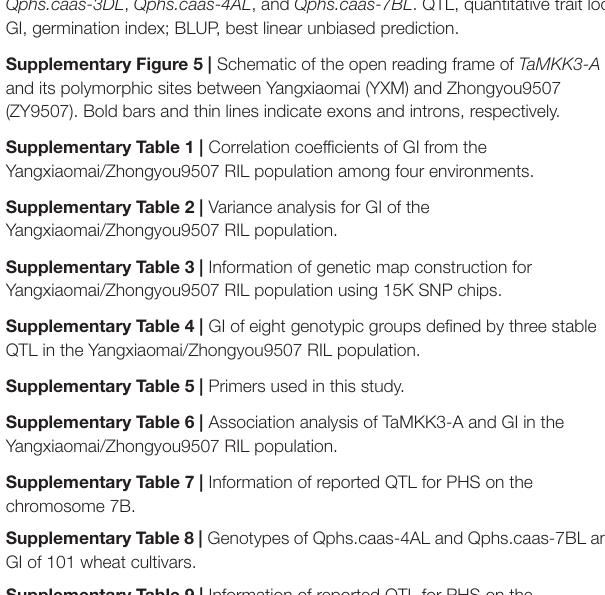
Supplementary Figure 3 | Genetic map of the Yangxiaomai/Zhongyou9507 RIL population determined from 15K SNP arrays. RIL, recombinant inbred line; SNP, single-nucleotide polymorphism. Supplementary Figure 4 | Linear regression between the resistance allele number of the QTL and GI in four environments and BLUP values in the Yangxiaomai/Zhongyou9507 population. The QTL include Qphs.caas-3AL , Qphs.caas-3DL , Qphs.caas-4AL , and Qphs.caas-7BL . QTL, quantitative trait loci; GI, germination index; BLUP, best linear unbiased prediction. Supplementary Figure 5 | Schematic of the open reading frame of TaMKK3-A and its polymorphic sites between Yangxiaomai (YXM) and Zhongyou9507 (ZY9507). Bold bars and thin lines indicate exons and introns, respectively.